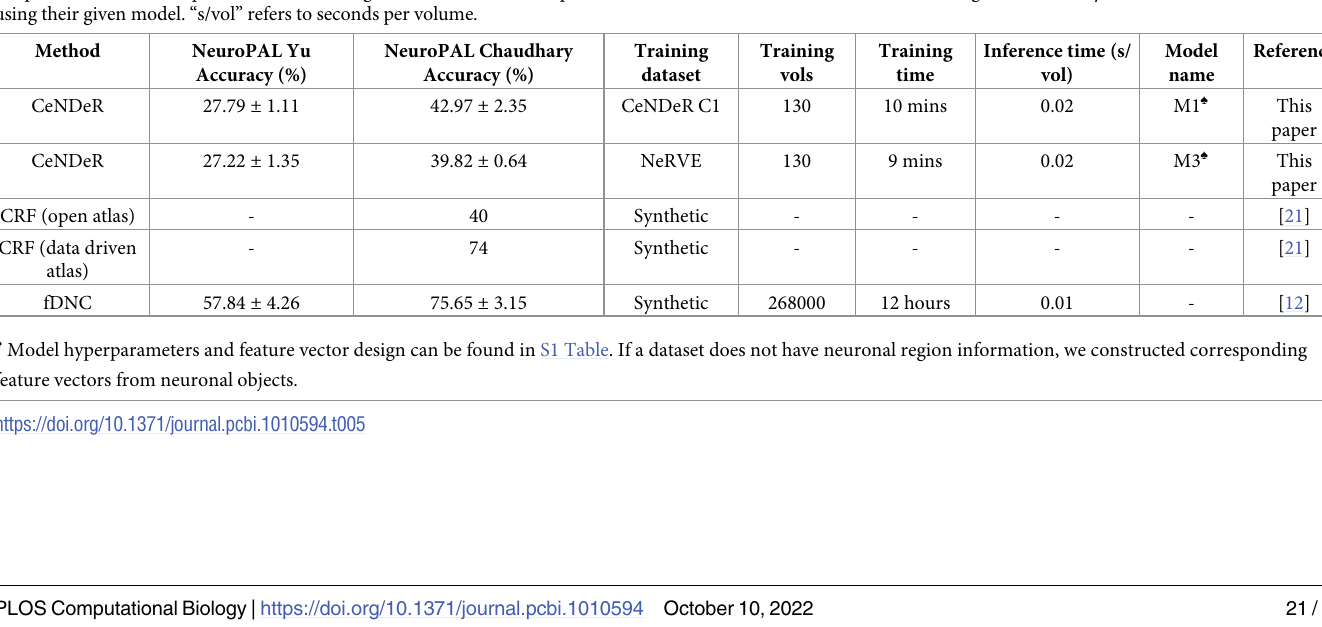
♠ Model hyperparameters and feature vector design can be found in S1 Table. If a dataset does not have neuronal region information, we constructed corresponding feature vectors from neuronal objects. ?